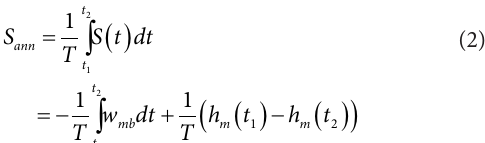
FIGURE 3 | The seasonal variation in (A) MLD (m), (B) SST (°C) averaged between 30°N and 40°N in the north Pacific. The shaded and black contours are for WOA13, and the while contours are for